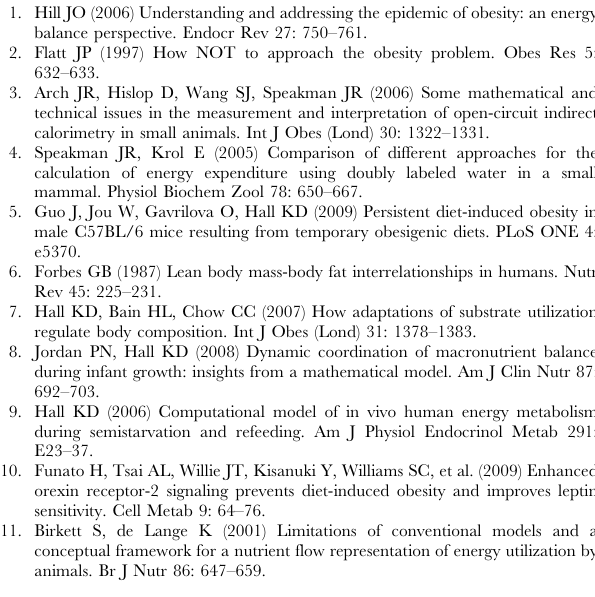
black lines in Figure 2 and represent the average of the individual intakes shown by the data points. Body weight measurements for the C, HF, and EN groups of mice were fit using third order polynomial functions of time, as depicted by the solid curves in Figure 1A. Following the diet switch in the HF-C and EN-C groups, the body weight curves were fit to exponential